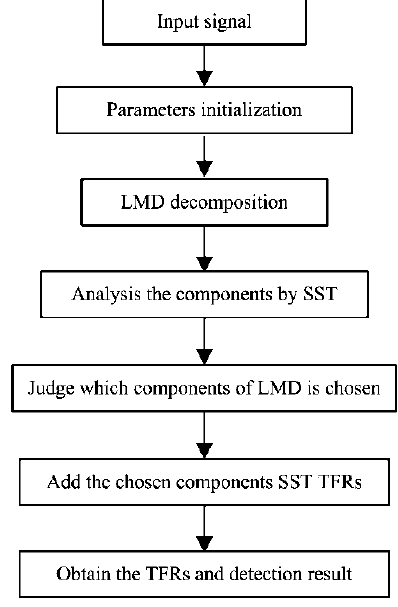
Figure 5. The processing flowchart of the proposed method.